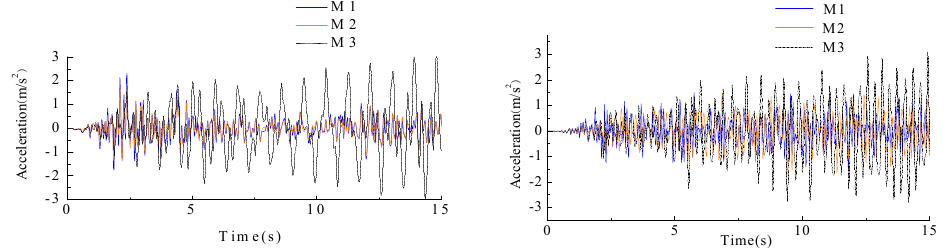
Figure 15. Time–history curves of the midpoint’s acceleration of soil.